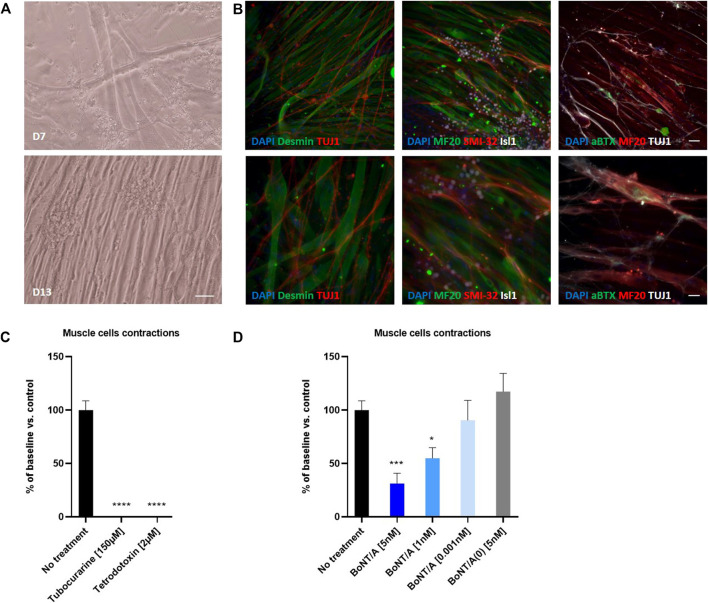
Coculture of human myotubes and human motor neurons. (A) Phase images of co-cultures maintained in P96 during 7 or 13 days. Scale bar: 25 µm. (B) Immunocytochemical characterization of NMJ formation. Muscular fibers are identified with Myosin/MF20 or Desmin, Motor Neurons neurites are identified with TUJ1 or SMI-32 and MN nuclei are identified with Islet 1 and Acetylcholine receptor with alpha-bungarotoxin. Nuclei are represented in blue (DAPI). Top: 20X images; scale bar: 50 µm. Bottom: 40X images; scale bar: 25 µm. (C) Effect of TTX and Tubocurarine on muscle cells contractions after 6 h of exposure. (D) Dose-response effects of BoNT/A on contraction of myotubes after 6 h of exposure. *p < 0.05; **p > 0.01; ***p < 0.001; ****p < 0.0001.